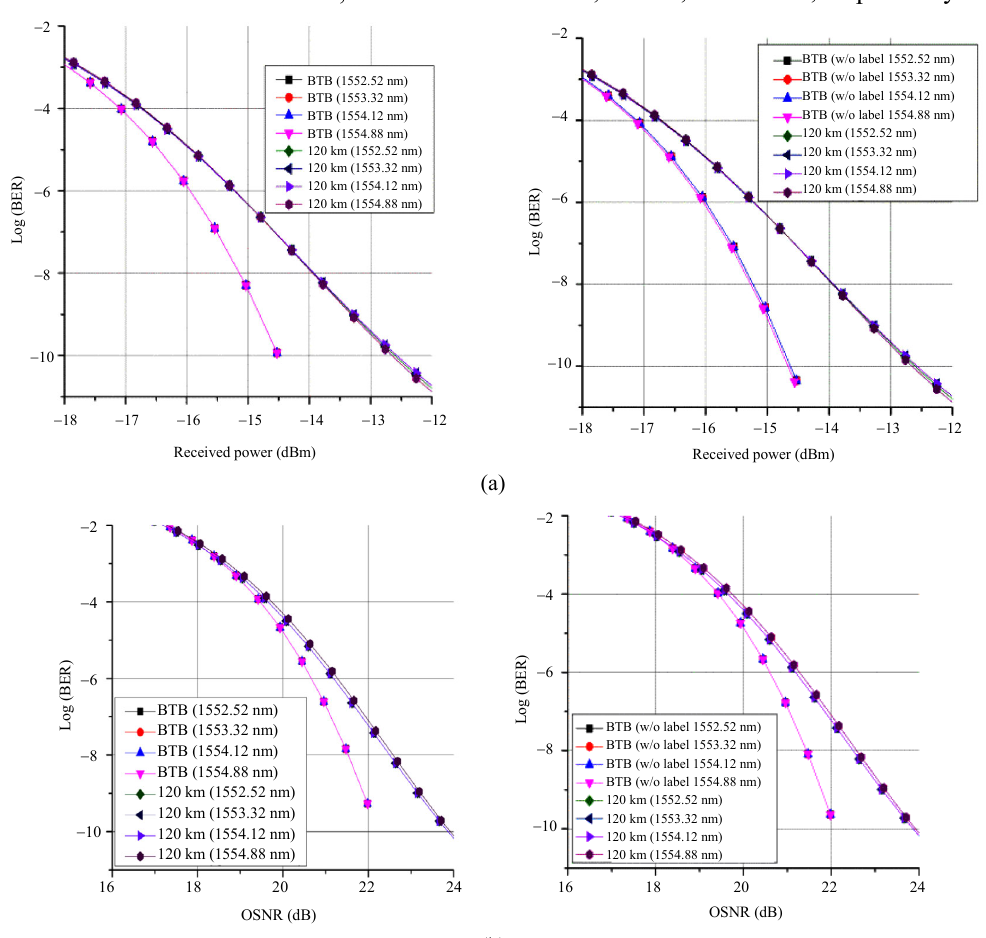
Fig. 7 Transmission performance of payload after 120 km: (a) performance with and without label: BER vs. ROP and (b) performance with label and without label: BER vs.